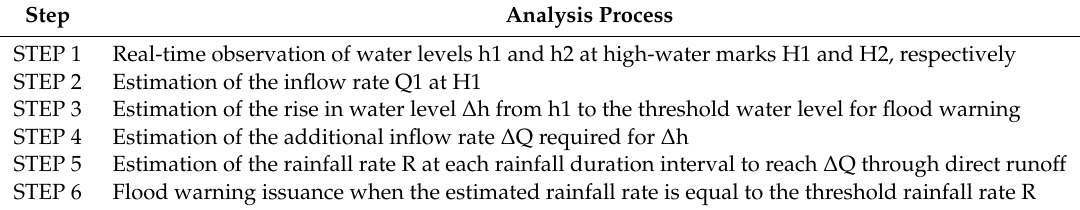
Table 1. Water level fluctuation analysis process based on upstream and downstream water level observations.